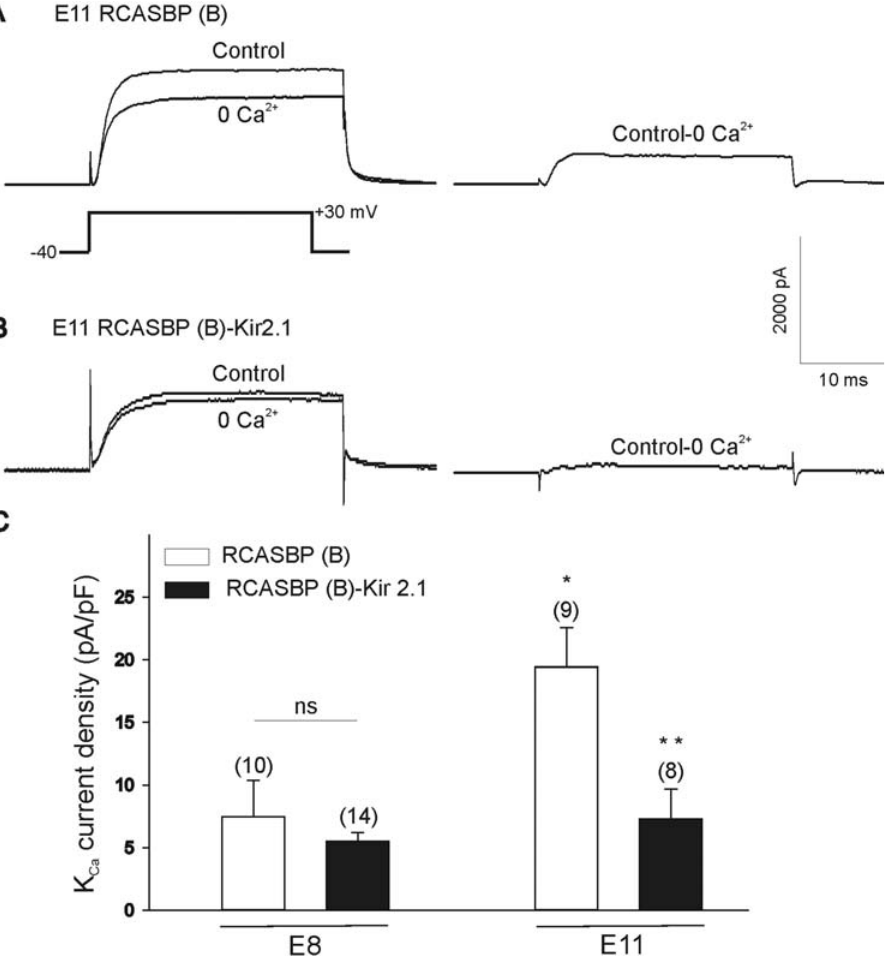
Figure 11. Effect of Kir2.1 expression on the functional expression of K Ca currents in embryonic lumbar motoneurons developing in vivo. A,B) Outward currents in E11 motoneurons from chicken embryos infected with RCASBP(B) or RCASBP(B)-Kir2.1 constructs, respectively. Outward currents were evoked in control and Ca 2 + -free saline (right traces in A and B ) following a 25 ms depolarizing step to + 30 mV from a holding potential of 2 40 mV (stimulation protocol is shown as the left bottom trace in A ). Net Ca 2 + -dependent outward currents were obtained by digital subtraction of raw traces (right traces in A and B ). C) Kir2.1 expression resulted in a significant inhibition of K Ca current density in E11 lumbar motoneurons. Notice that at K Ca expression is significantly low in chicken motoneurons isolated at E8 in both RCASBP(B) or RCASBP(B)-Kir2.1 infected embryos. K Ca expression increased , 3 fold in RCASBP(B)-infected embryos by E11 but was significantly reduced in RCASBP(B)-Kir2.1 infected embryos. * represents p # 0.05 vs. E8 RCASBP(B), ** p # 0.05 vs. E11 RCASBP(B)-Kir2.1.